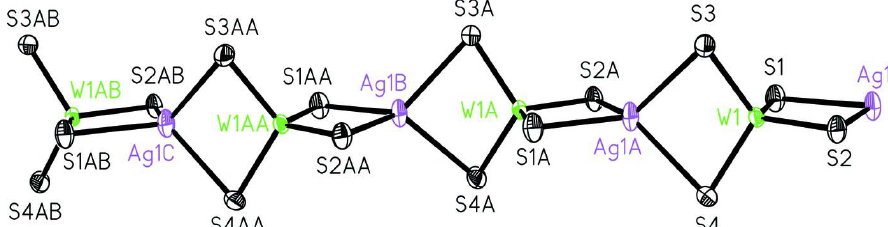
A portion of the anionic chain in the title compound, with atom labels and 30% probability displacement ellipsoids. (symmetry codes: i x , - y + 1/2, z - 1/2; ii x , y , z - 1; iii x , - y + 1/2, z -